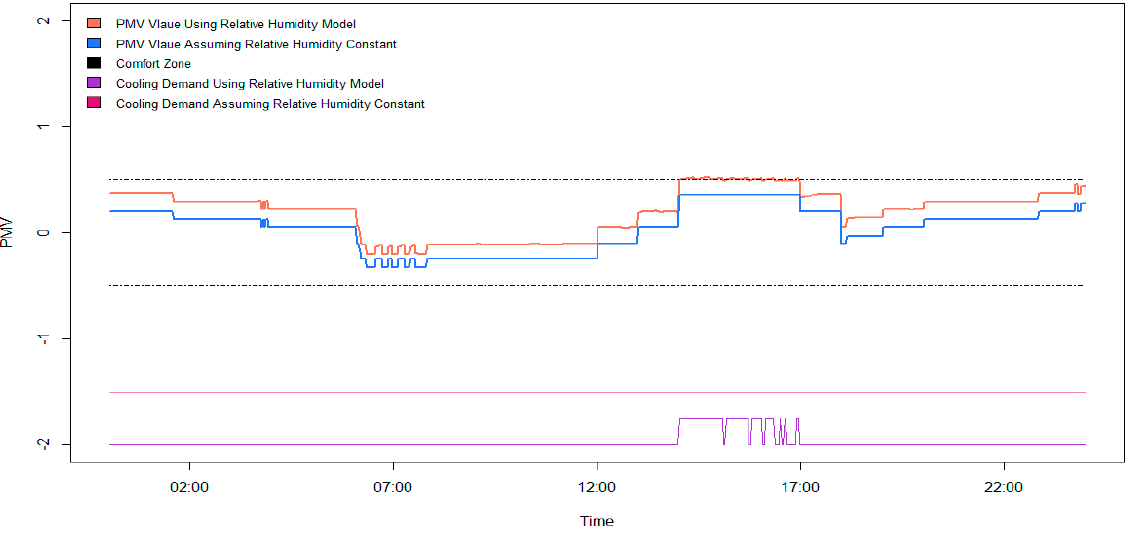
Figure 4. Time series plot of real-time PMV value and cooling demand for the including relative humidity model and assuming relative humidity as constant value.